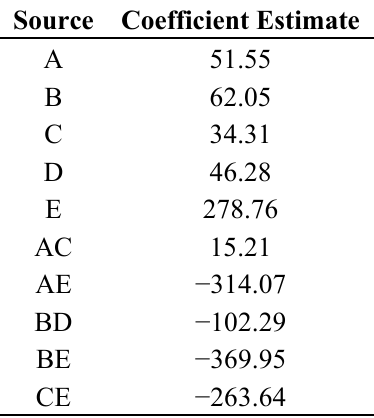
Table 3. Regression coefficient values for the final reduced